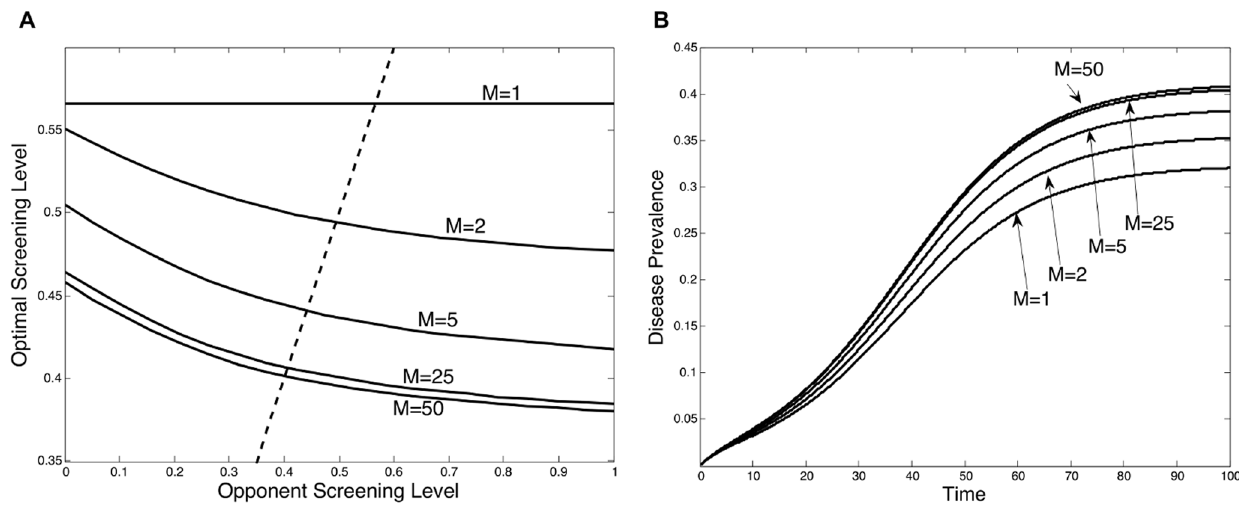
Figure 2. Changing the screening autonomy level. The strategic screening levels and associated disease prevalence are influenced by the degree of institutional autonomy M . (A) Best response curves depict an individual institution’s optimal screening rate d as a function of the screening level ~ dd chosen by the other institutions (i.e. its opponents). The equilibrium screening level, occurring at each curve’s intersection with the dashed line, increases as autonomy M decreases. (B) Disease prevalence over time, corresponding to the equilibrium screening levels in Figure A, is greater with increased autonomy M .